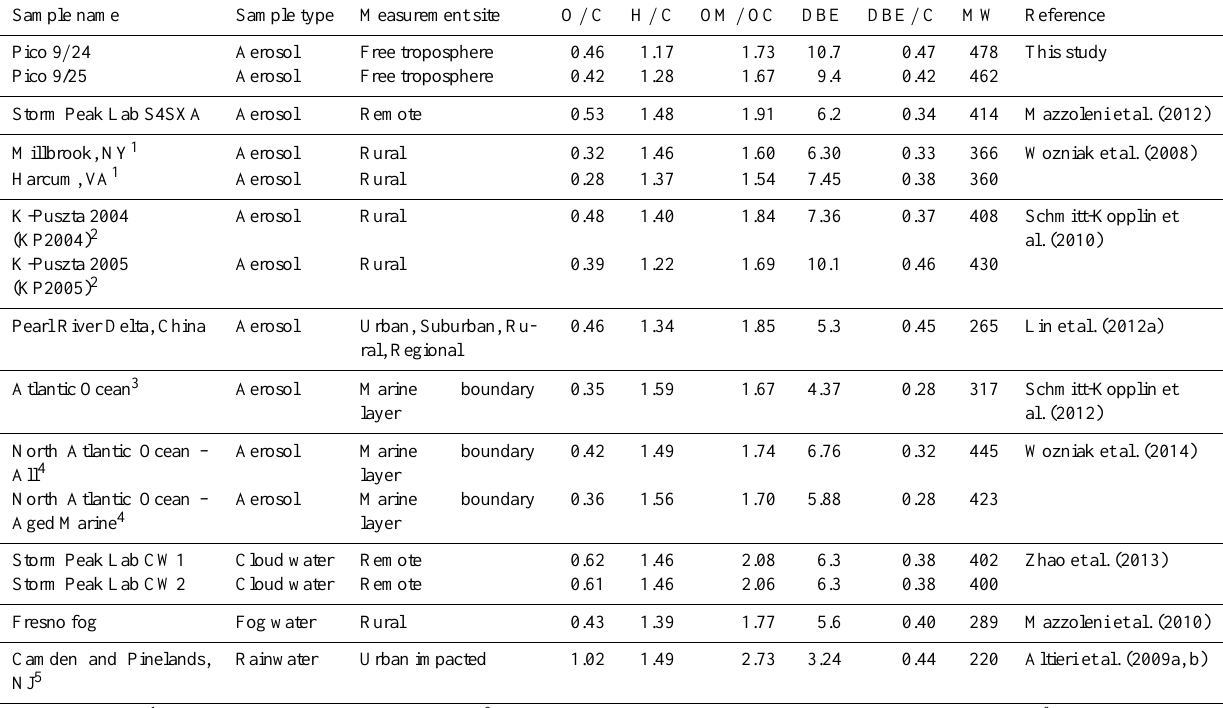
Values were calculated: 1 For each sample presented in Wozniak et al. (2008). 2 For only two samples (KP2004 and KP2005) presented in Schmitt-Kopplin et al. (2010). 3 For only one, marine aerosol, sample presented in Schmitt-Kopplin et al. (2012). 4 For all samples (and only one PCA group) presented in Wozniak et al. (2014). 5 By combining the negative mode FT-ICR MS data available in Altieri et al. (2009a) (CHO, CHOS and CHNOS) and Altieri et al. (2009b)